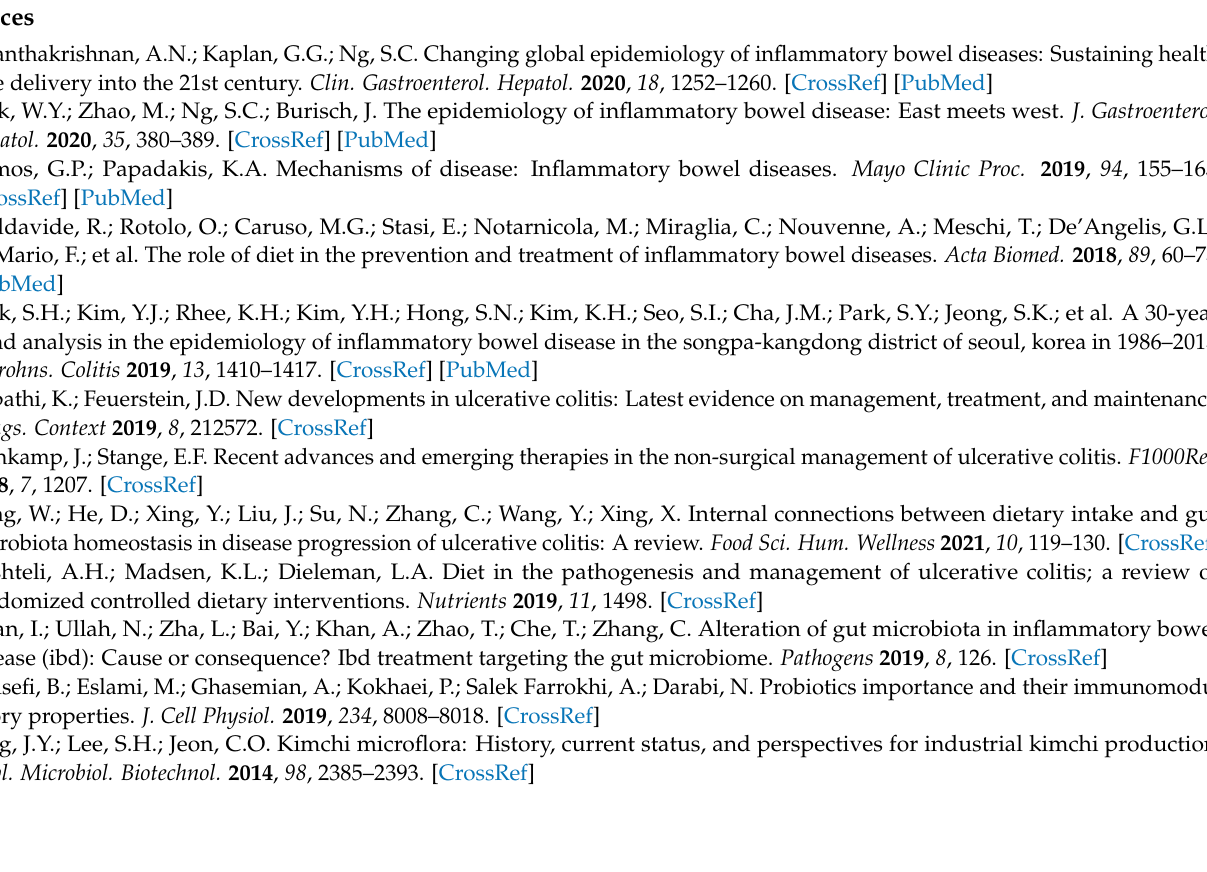
experiment periods. Table S1: Primer list used for quantitative real-time PCR. Table S2: Antibodies list used for Western